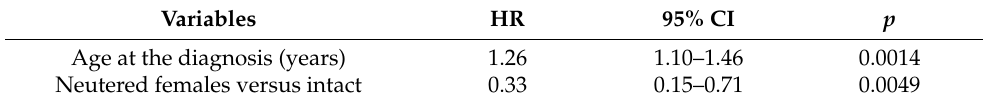
Table 3. Multivariate analysis of factors associated with overall survival in 84 dogs with MTs. Variables HR Age at the diagnosis